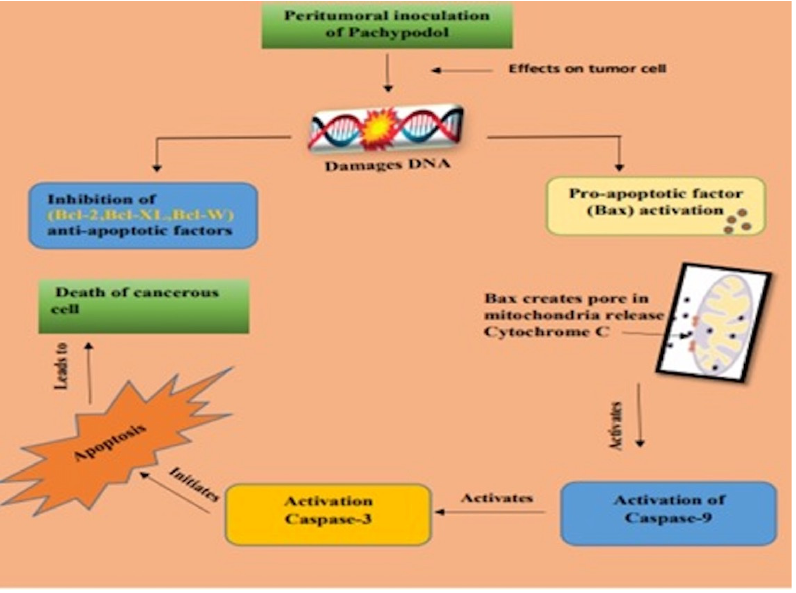
Figure 3. Apoptosis pathway activation by pachypodol.